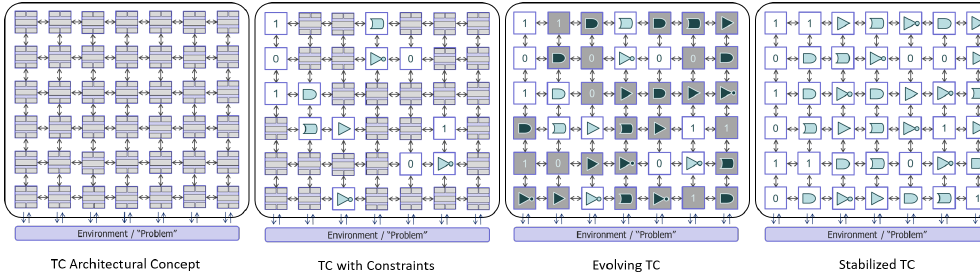
Figure 5. Conceptual schematic for the evolution of a Thermodynamic Computing System. ( Left ) The TC architecture is conceived as an array of nodes connected in a network. Each node may assume a variety of states/functions and the connections in the network may adapt as the TC evolves. The TC is connected to an external environment that represents the “problem” to be solved as a collection of potentials that will drive the evolution of the network. ( Center Left ) A programmer may fix the states/functions of some of the nodes (shown in white) and connections in order to constrain the evolution of the network and/or to help define the problem. ( Center Right ) Unconstrained nodes (shown in grey) fluctuate as the network evolves to a low energy configuration that is effective at transporting energy among the external potentials. ( Right ) The network may stop fluctuating if the environment is stable and converge upon a “solution”, but may also repeatedly fluctuate and stabilize to varying degrees if the environment is constantly